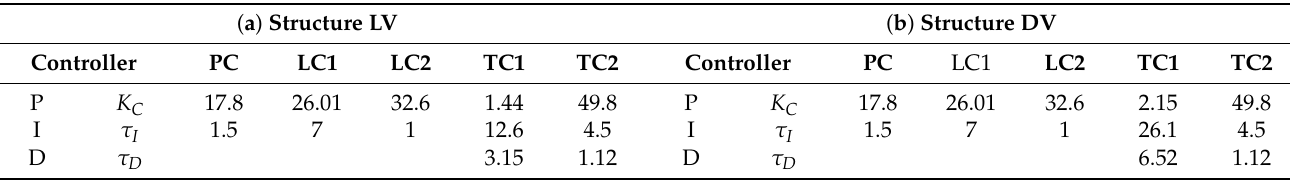
Table 6. Controller gain for the dual temperature